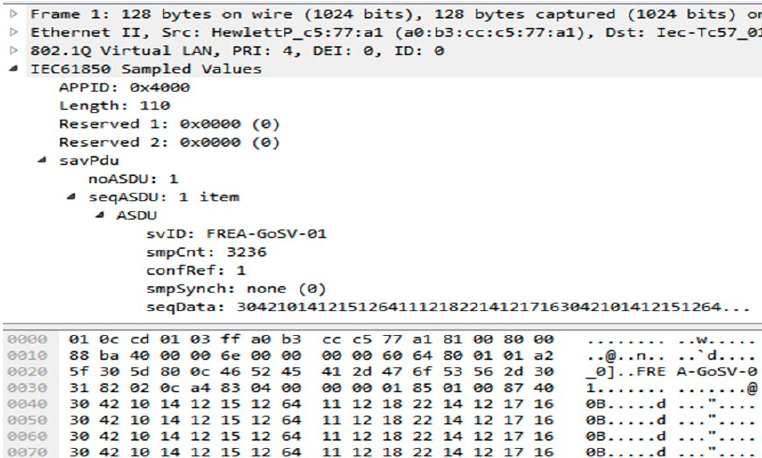
Figure 13. Wireshark capture of GOOSE frame values.